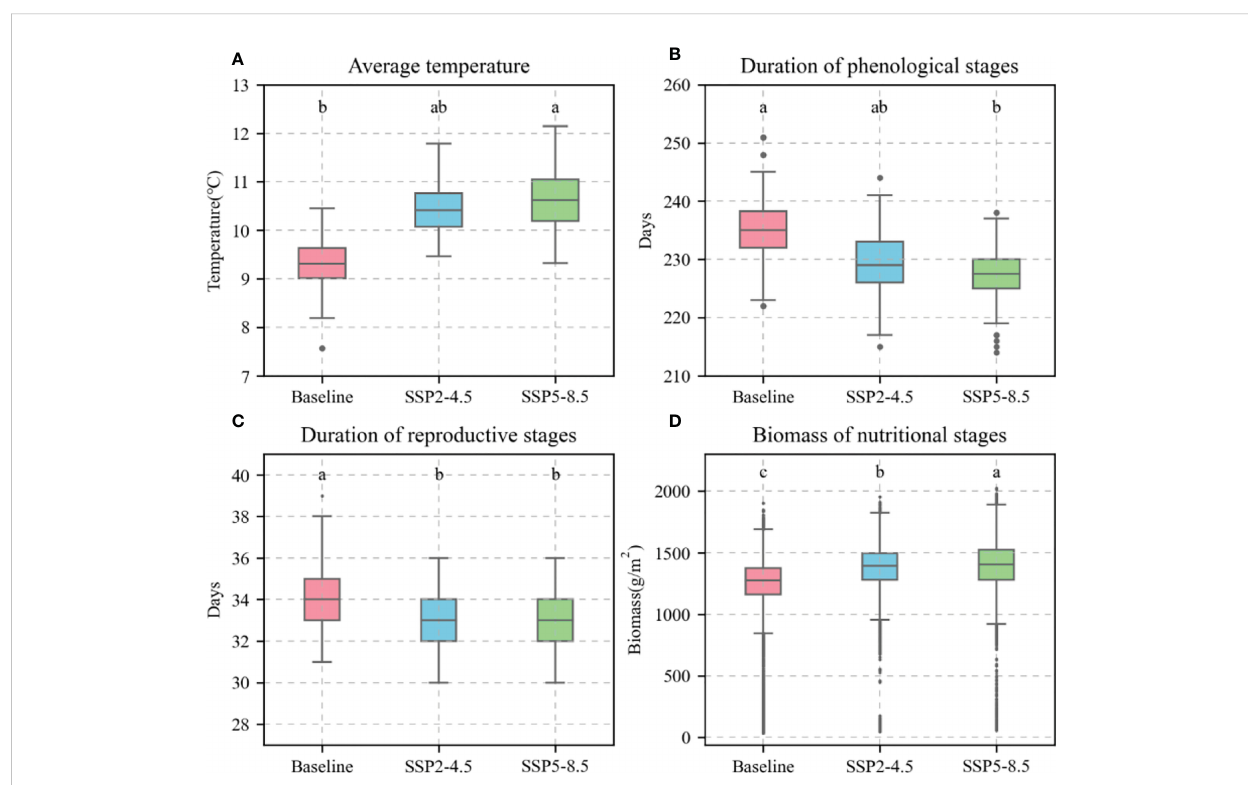
FIGURE 10 Average temperature, days, and biomass of 81 wheat varieties during phenological stages under different climate scenarios. (A) , average temperature; (B) , duration of phenological stages; (C) , duration of reproductive stages; (D) , biomass of nutritional stages. Red boxes represent baseline. Blue boxes represent SSP2-4.5. Green boxes represent SSP2-8.5. Different letters indicate signi fi cance at 0.05